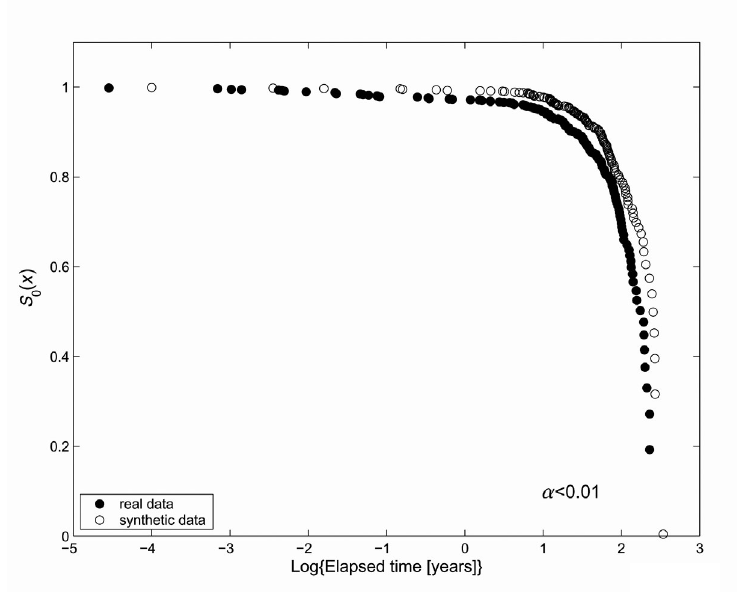
Fig. 2. Plot of empirical survivor functions for real and synthetic catalogs. The parameter α represents the sig- nificance level at which the null hypothesis of a common parent distribution can be rejected.